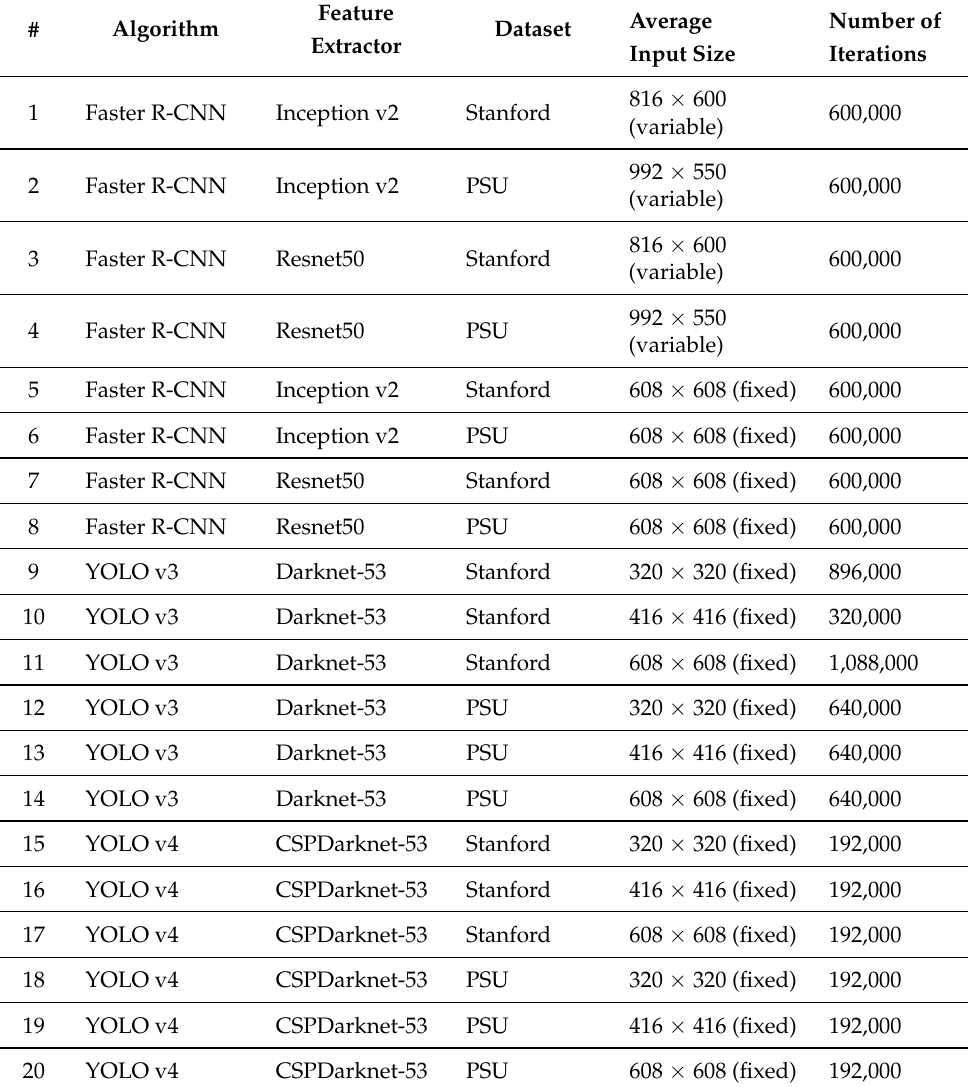
Table 7. Details of the main experiments. The default configuration of Faster R-CNN allows for a variable input size that conserves the aspect ration of the image. In this case, the input size shown is an